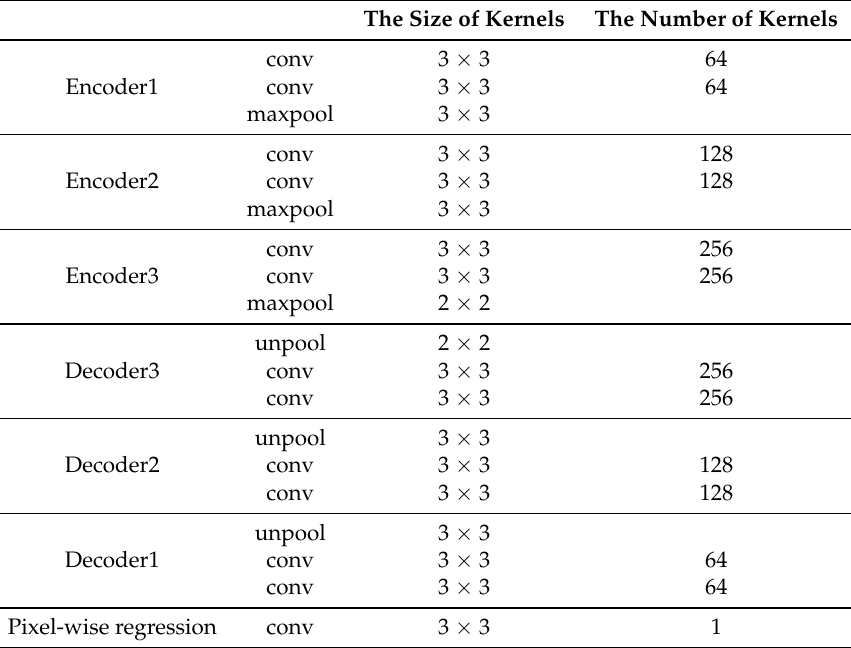
Table 1. The size and numbers of kernels of each layer of the proposed system. The Size of